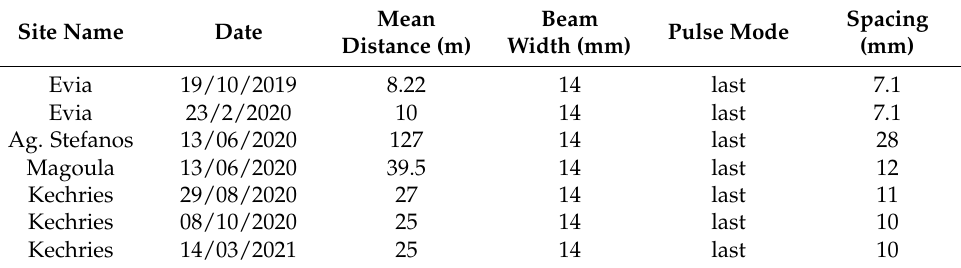
Table 3. TLS parameters for each scanned slope in Evia, Ag Stefanos, Magoula and Kechries 1